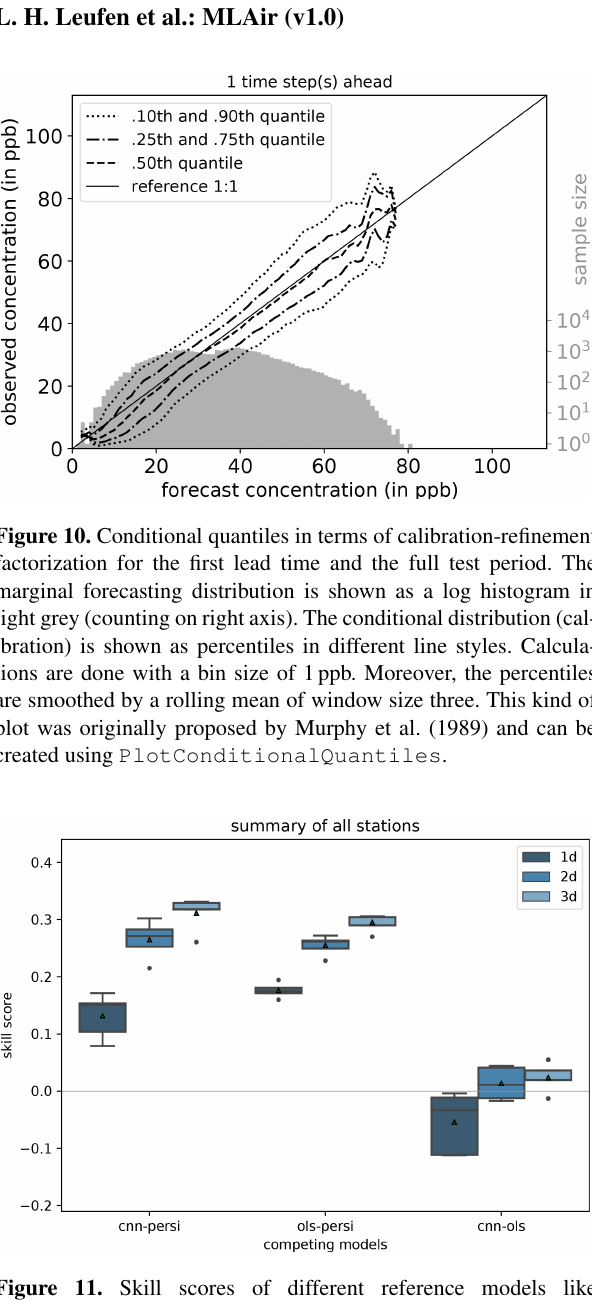
Figure 11. Skill scores of different reference models like persistence (persi) and ordinary multi-linear least square (ols). Skill scores are shown separately for all forecast steps (dark to light blue). This graph is generated by invoking PlotCompetitiveSkillScore